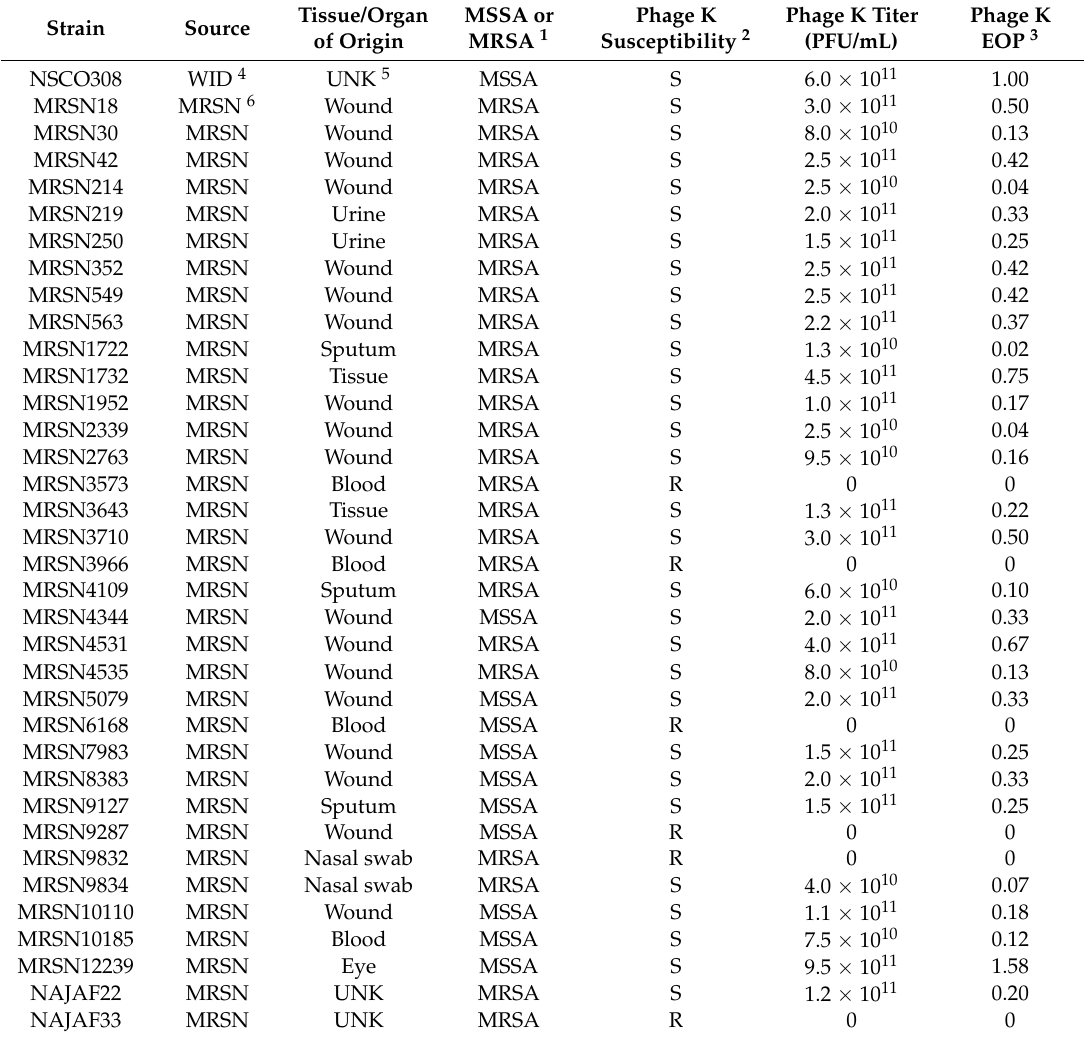
Table 1. S. aureus strains used in this